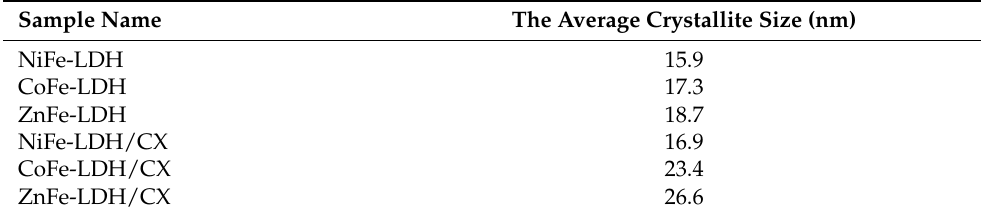
Table 1. Crystallite size of the synthesized